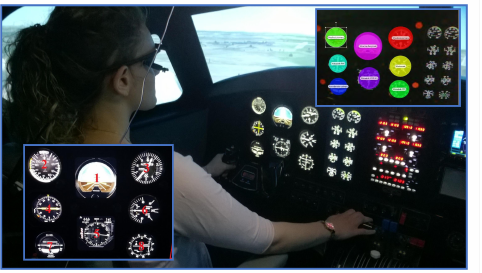
Figure 1. General view of the pilot attention measurement strategy during